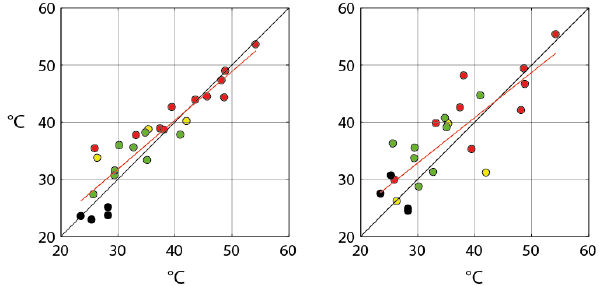
Fig. 5. Computed versus measured net radiation for the SEBS, TSEB and S-SEBI (left panel) and ICARE (right panel). Color code: red: LAI < 0.4; yellow: 0.4 ≤ LAI < 0.8; green: 0.8 ≤ LAI < 1.2; navy-blue: 1.2 ≤ LAI < 2.0; black: LAI ≥